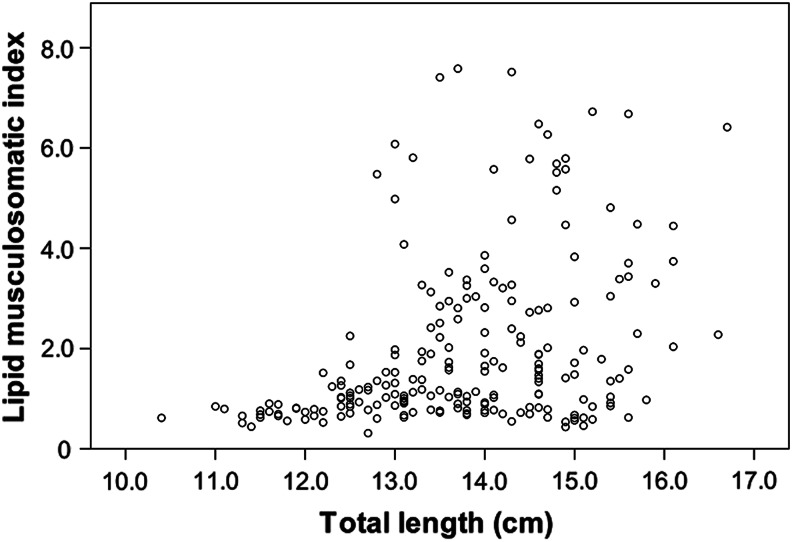
Scatterplot of lipid musculosomatic index (ILM) of anchovies in relationship to total body length (n = 210).